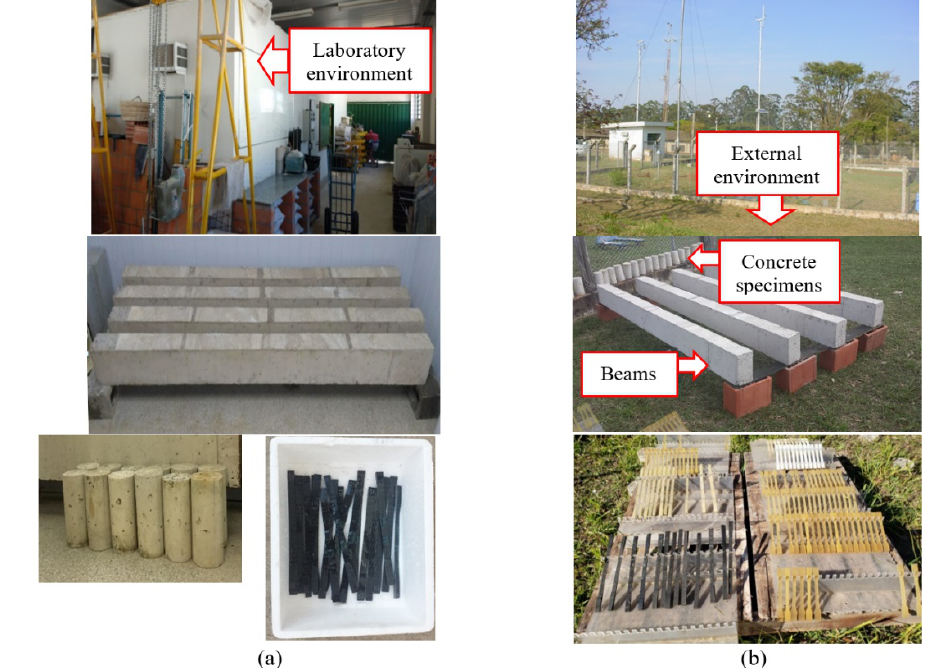
Figure 8. Exposure environments: (a) isolated and protected chamber and (b) exposure to weather (outdoor environment)